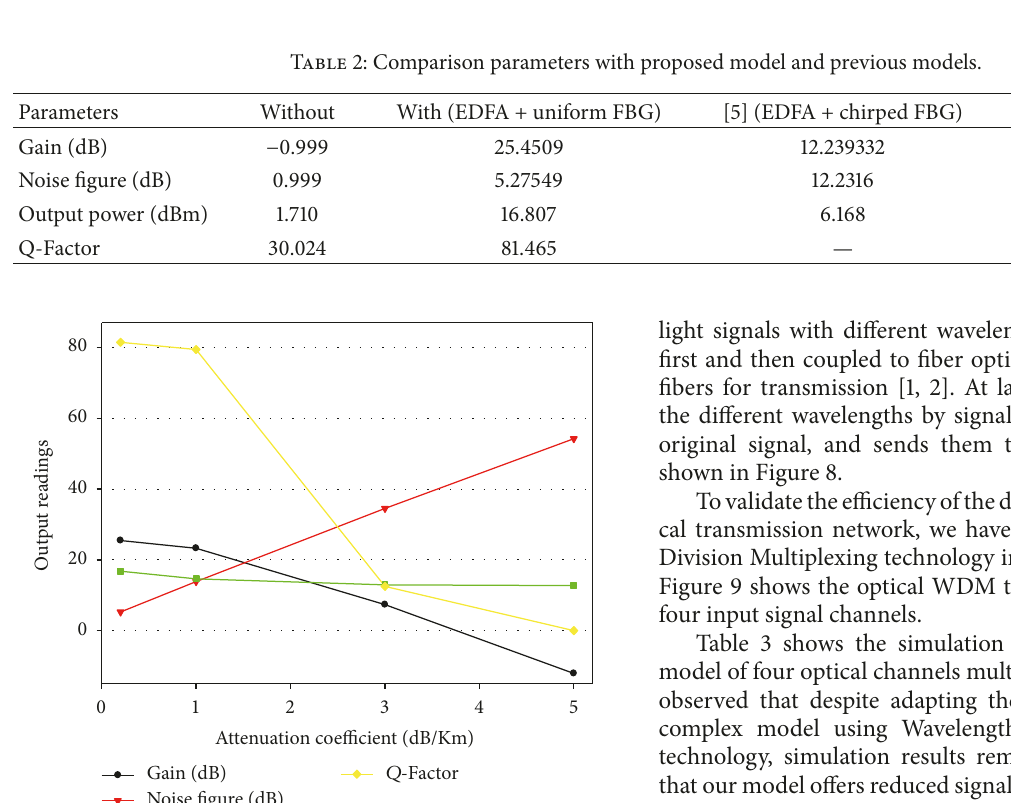
Figure 6: Eye diagrams for different values of attenuation coefficient (dB/Km).